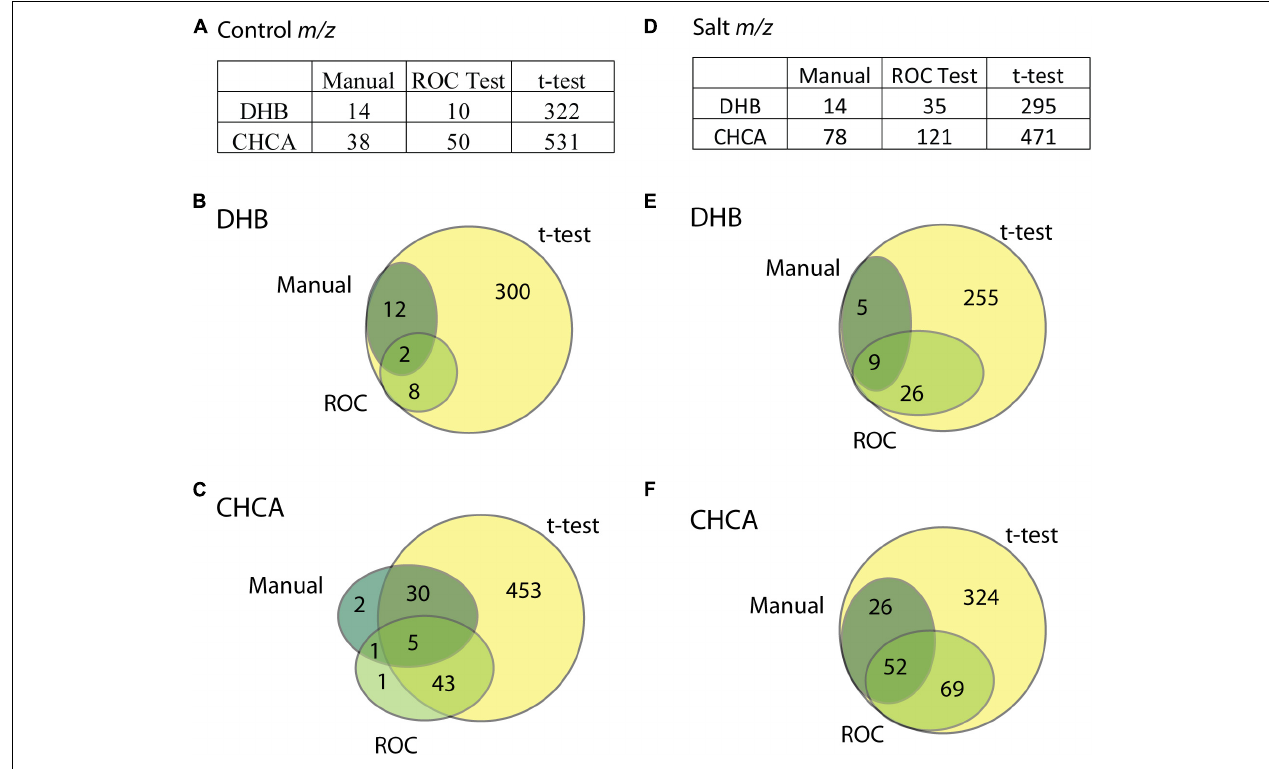
FIGURE 4 | Overview of the SCiLS statistical analysis on the control versus salt nodules and roots. (A) Gives the number of significant m/z values determined for three analysis types in control nodules: manual analysis, discriminative analysis in SCiLS (ROC), and hypothesis test ( t -test) in SCiLS software. (B,C) Compare the three types of analysis for DHB and CHCA matrix, respectively, using Venn diagrams. (D–F) Gives the same data as (A–C) only for significant m/z in the salt